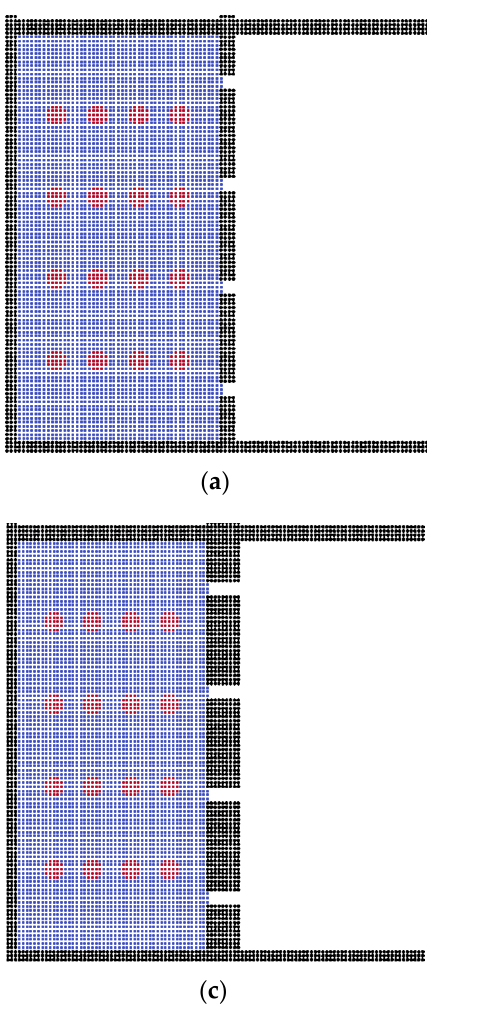
tions, thickness = 10 and 30 μ m, respectively; ( b , d ) are the results. thickness = 10 and 30 µ m, respectively; ( b , d ) are the